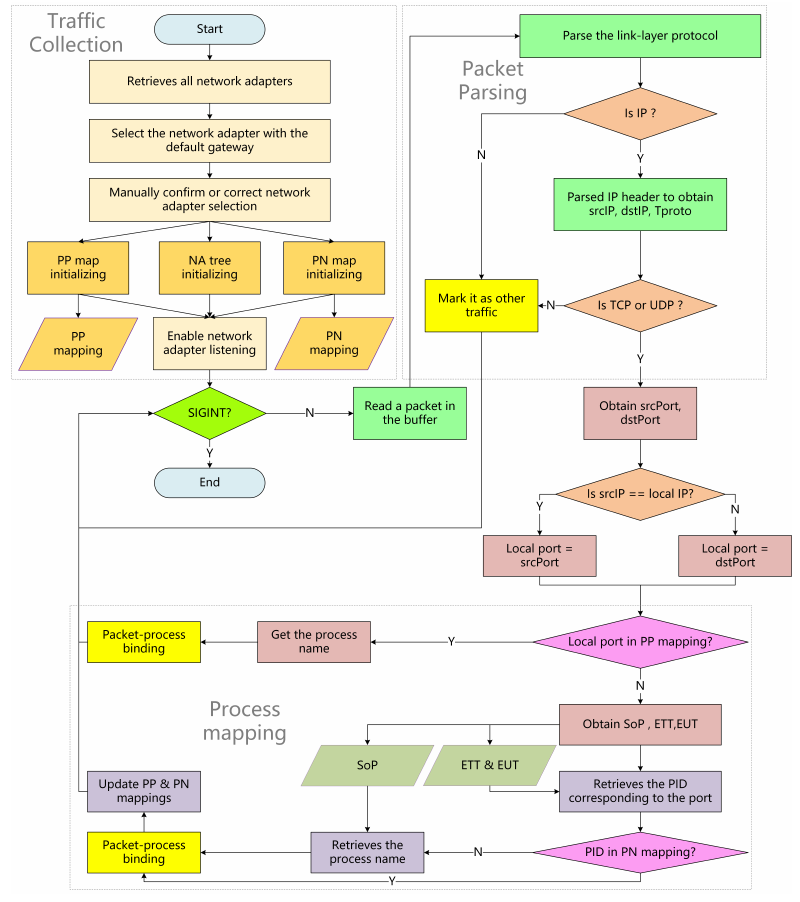
Figure 4. A3C-Windows sample collection and